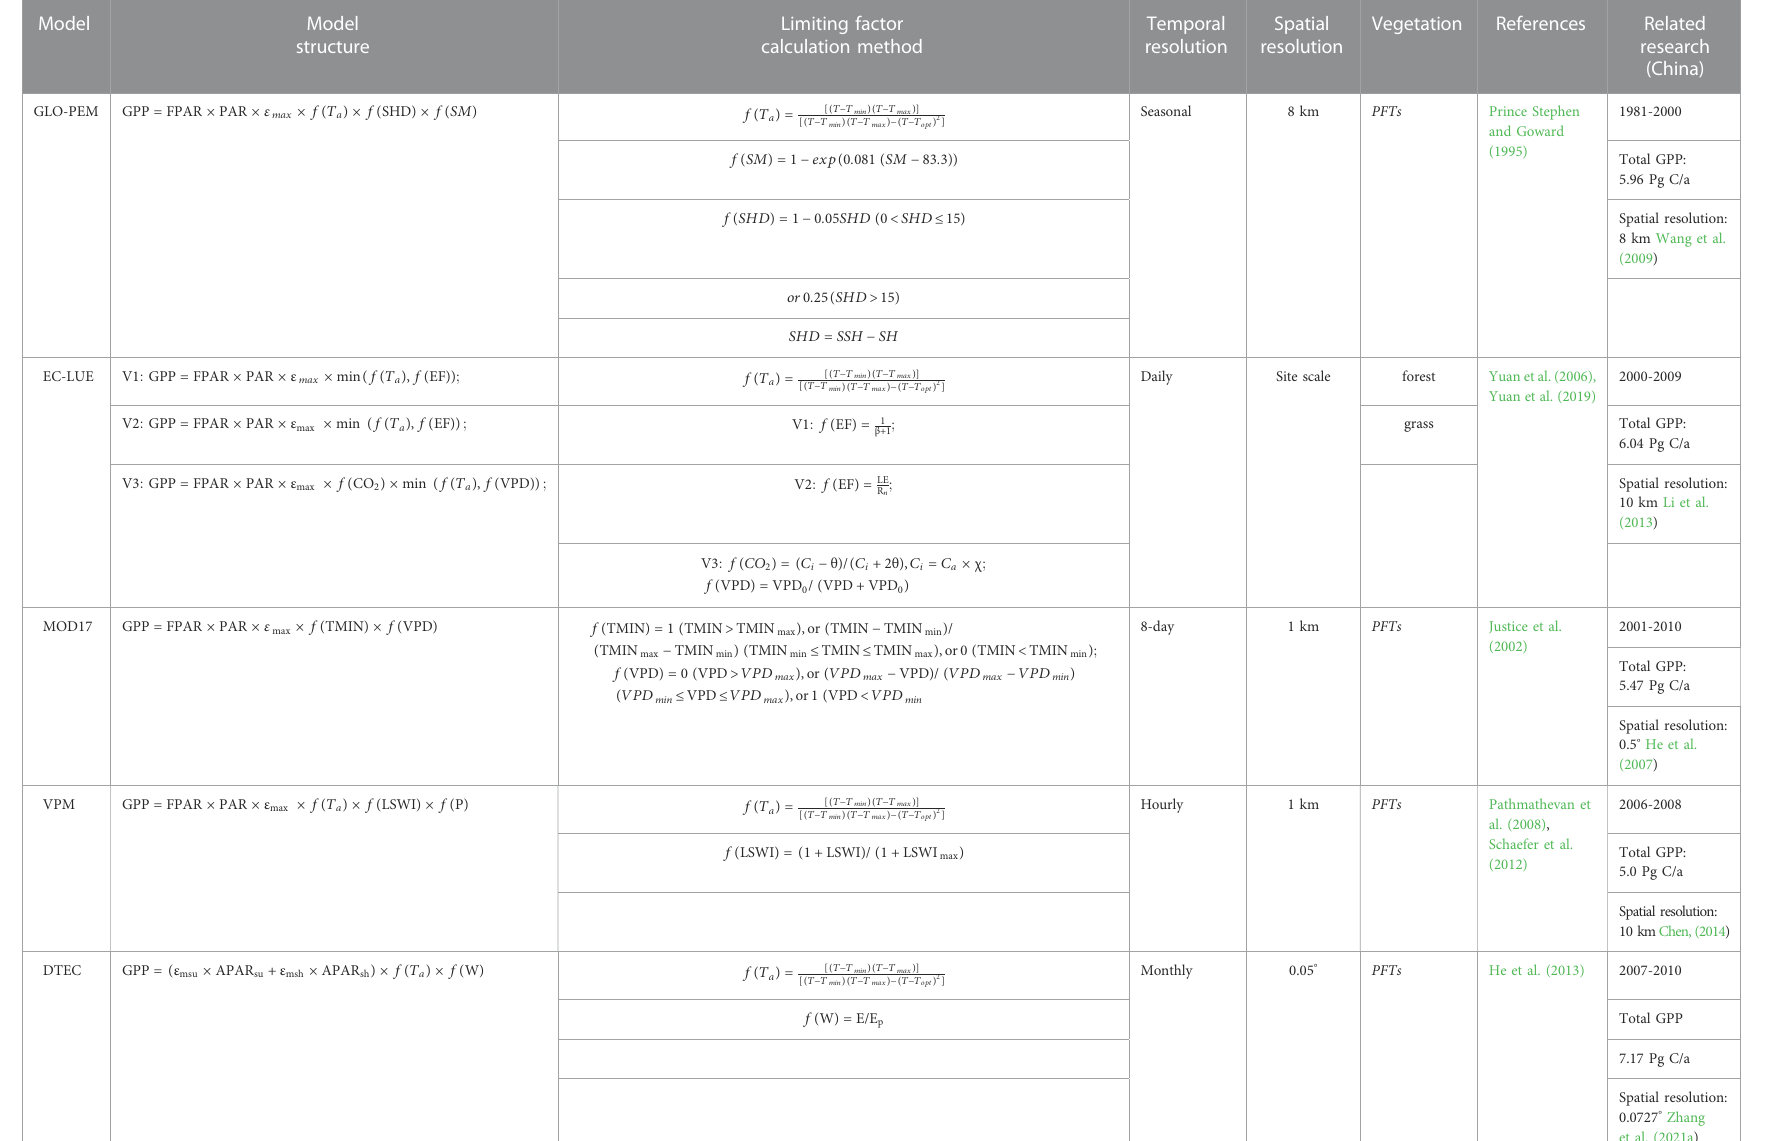
TABLE 1 LUE model